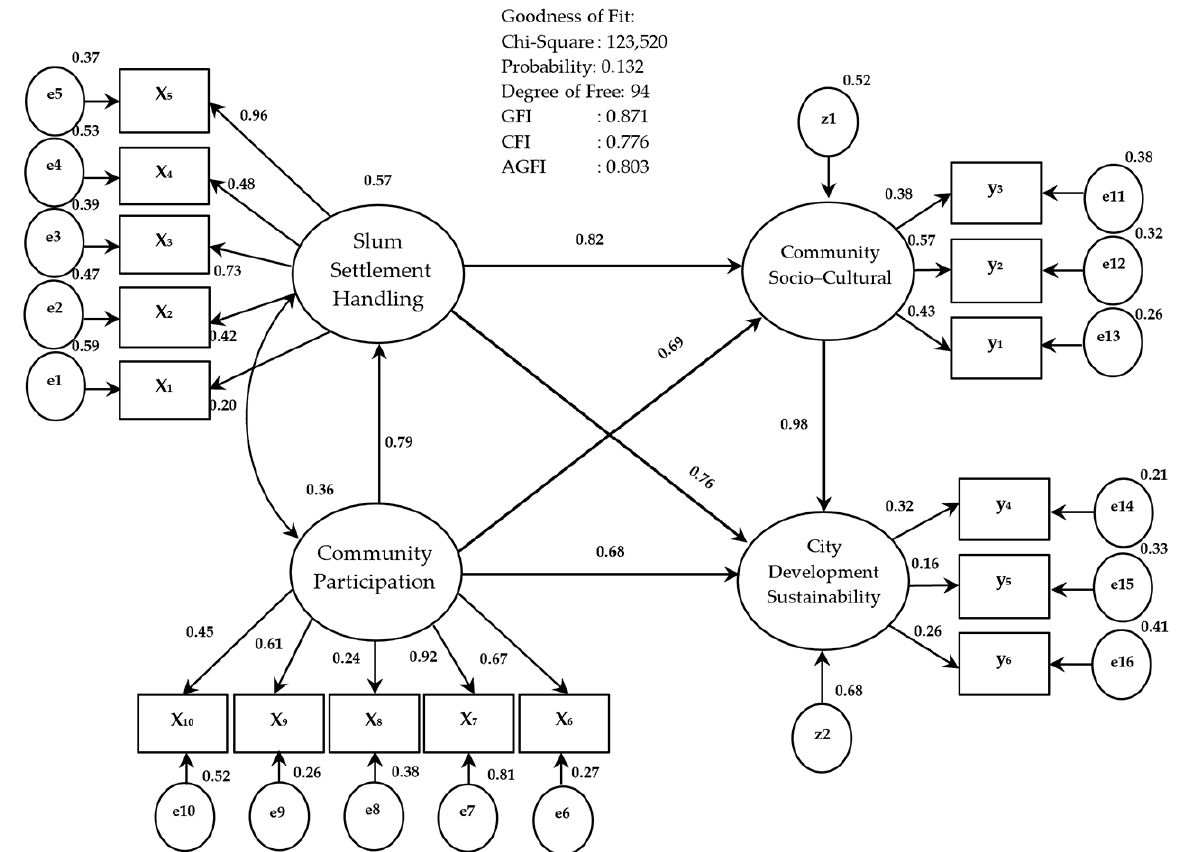
Figure 5. The estimation model for the handling of slum settlements, community participation, and socio-cultural changes in the community towards the sustainable development of Makassar